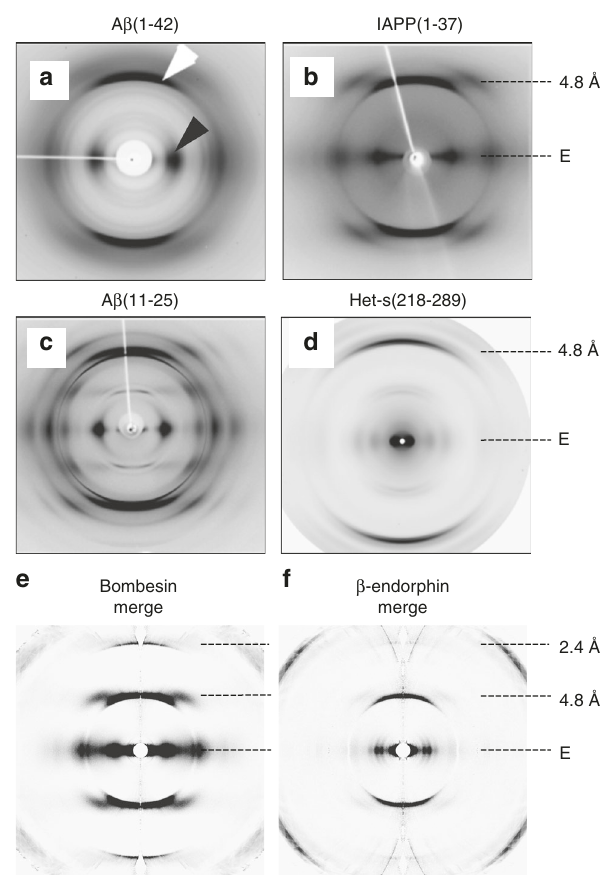
Fig. 6 Comparison of conventional X-ray patterns to merged XFEL